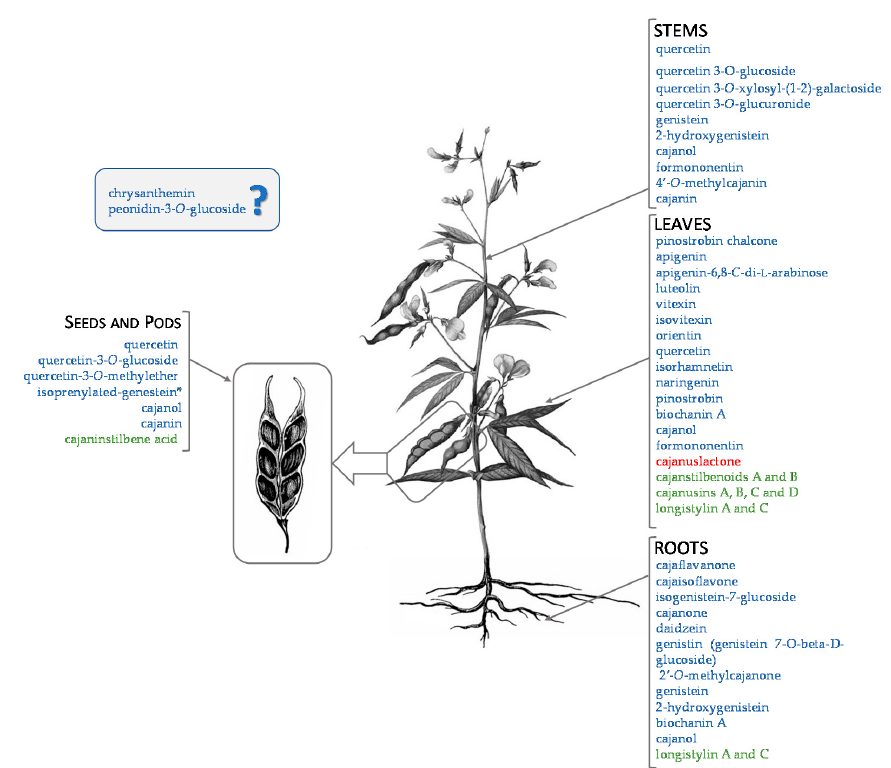
Figure 6. Localization of the flavonoids (blue), stilbenoids (green) and coumarin (red) accumulated